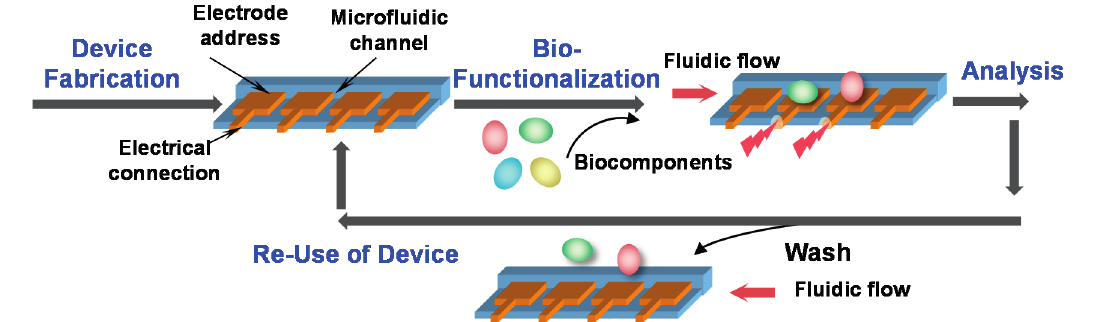
Figure 2. Generic fabrication approach for assembling the bio-device